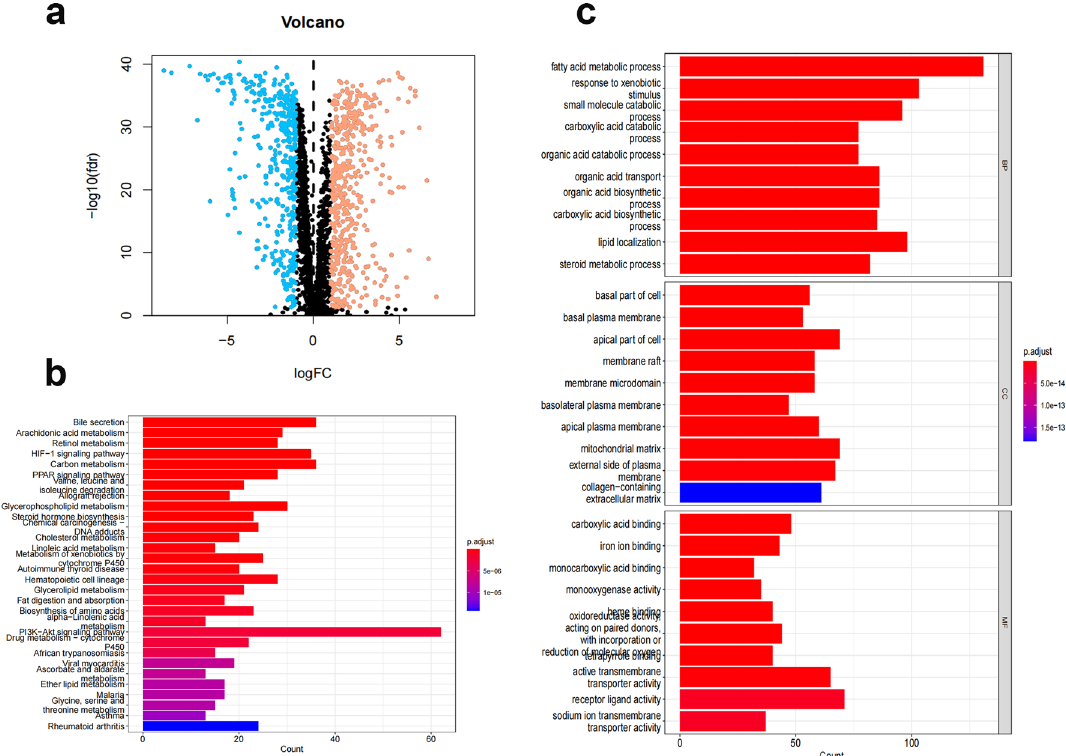
Figure 2. GO and KEGG analysis of FAM-associated DEGs in cancerous and adjacent tissues. ( a ) The 907 FAM-related genes in ccRCC. Yellow dots indicate upregulated genes, and blue dots indicate downregulated genes. ( b ) KEGG analysis of FAM-associated DEGs. ( c ) GO analysis of FAM-associated DEGs. GO, Gene Ontology; KEGG, Kyoto Encyclopedia of Genes and Genomes; DEGs, differentially expressed genes; FC, fold change; FDR: false discovery rate; BP, biological process; CC, cellular component; MF, molecular